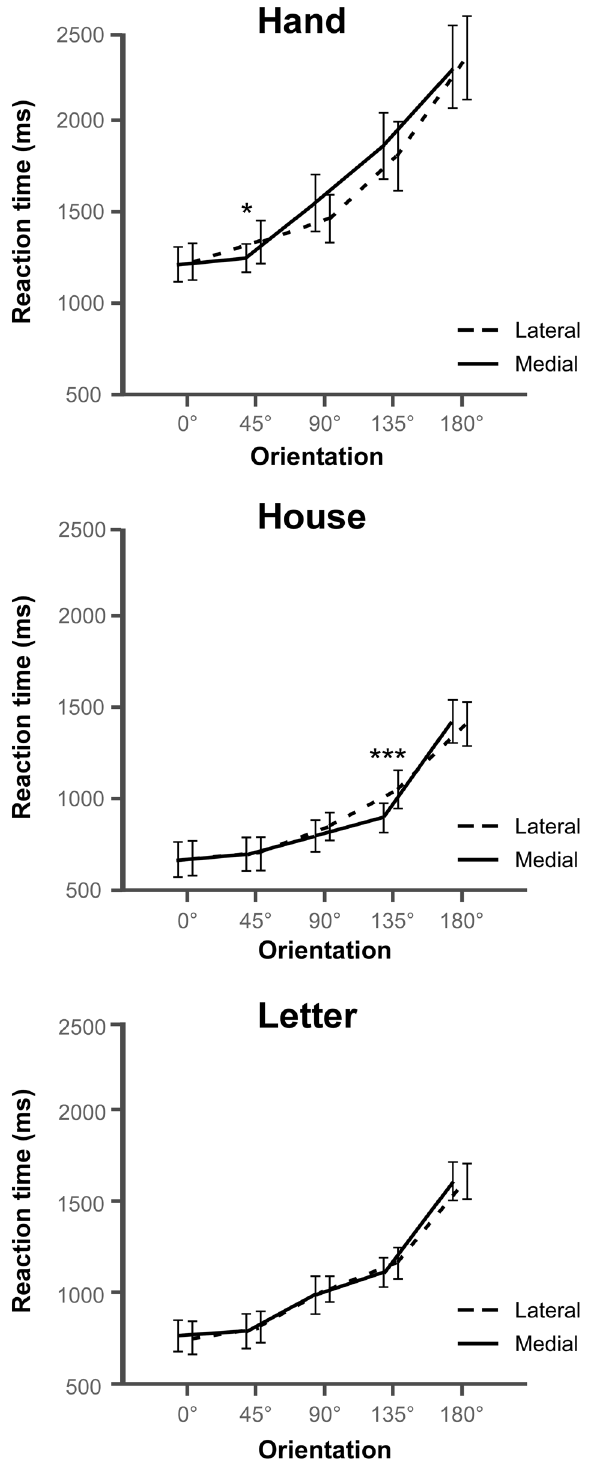
Figure 4. Mean reaction times (RT) according to stimulus type, rotation and orientation of the stimuli. The lines represent the comparison of RTs between the lateral (dashed lines) and medial (plain lines) rotations according to the orientation of the stimuli (i.e. 0° vs. 45° vs. 90° vs. 135° vs. 180°) for each type of stimulus (i.e. hand vs. house vs. letter). Error bars represent the 95% confidence intervals adapted according to the method of Cousineau 69 . *p ≤ 0.05, ***p ≤